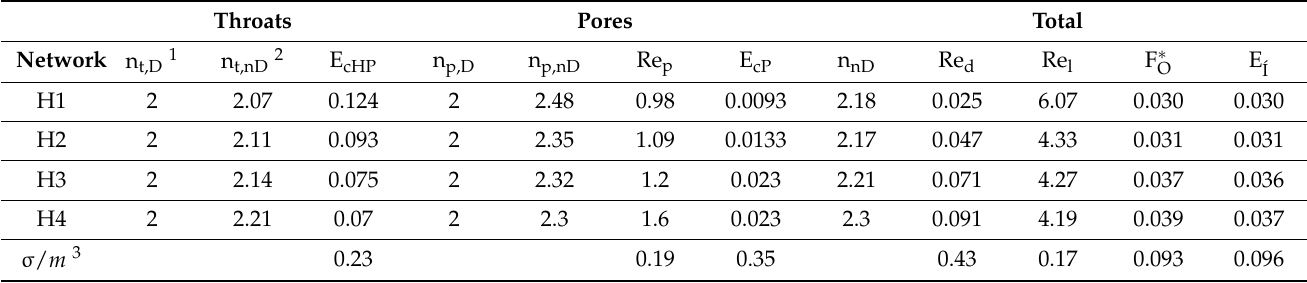
Table 3. The exponents of Equations (20) and (21) and the criteria for the onset of non-Darcy regime.